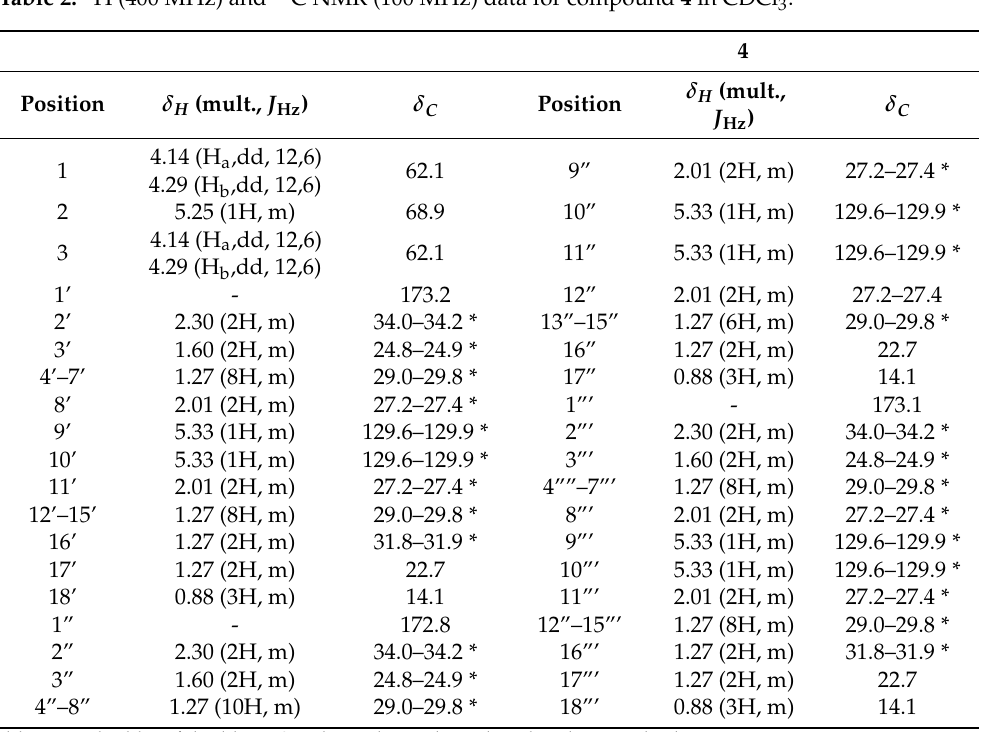
Figure 4. Chemical structure of compound 4 , triacylglycerol. Table 2. 1 H (400 MHz) and 13 C NMR (100 MHz) data for compound 4 in CDCl 3 .